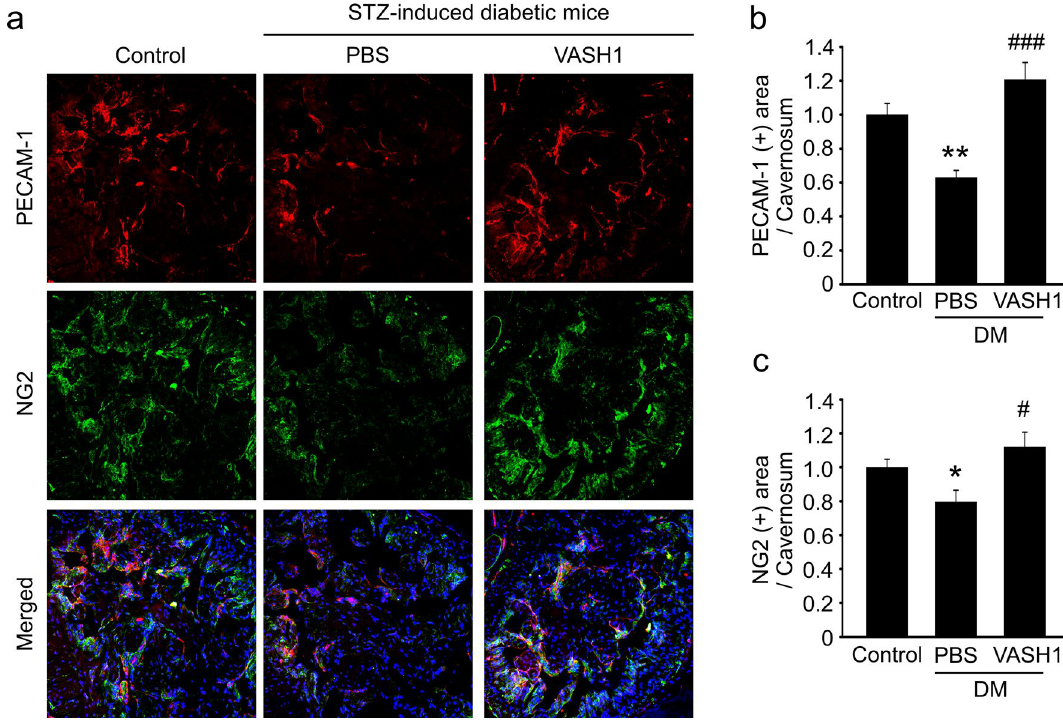
Figure 4. VASH1 protein transfer restores cavernous endothelial cell and pericyte content in diabetic mice. ( a ) PECAM-1 (red) and NG2 (green) staining in cavernous tissue from age-matched control and streptozotocin- induced diabetic mice 2 weeks after receiving repeated intracavernous injections of PBS (days − 3 and 0) or VASH1 protein (days − 3 and 0; 4 μg/20 μL). Scale bar = 100 µm. ( b , c ) Quantification of cavernous endothelial cell and pericyte content by Image J. Each bar depicts the mean (± SE) values from N = 6 animals per group. * P < 0.05, ** P < 0.01 vs. control group. # P < 0.05, ### P < 0.001 vs. PBS-treated DM group. DM diabetes